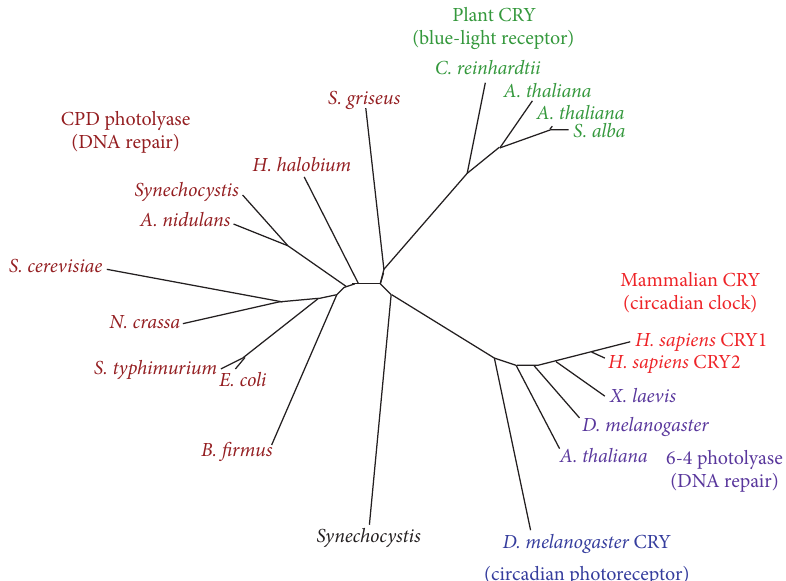
Figure 1: Phylogenetic tree of photolyase/cryptochrome family proteins (adapted from [2]).